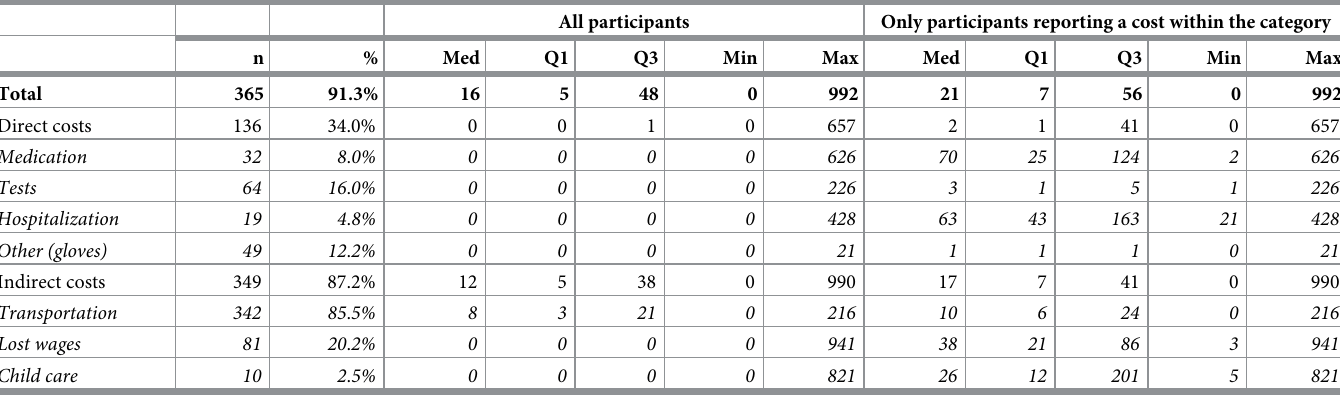
Table 3. Annual costs of HIV care (N = 400) (2019 USD).